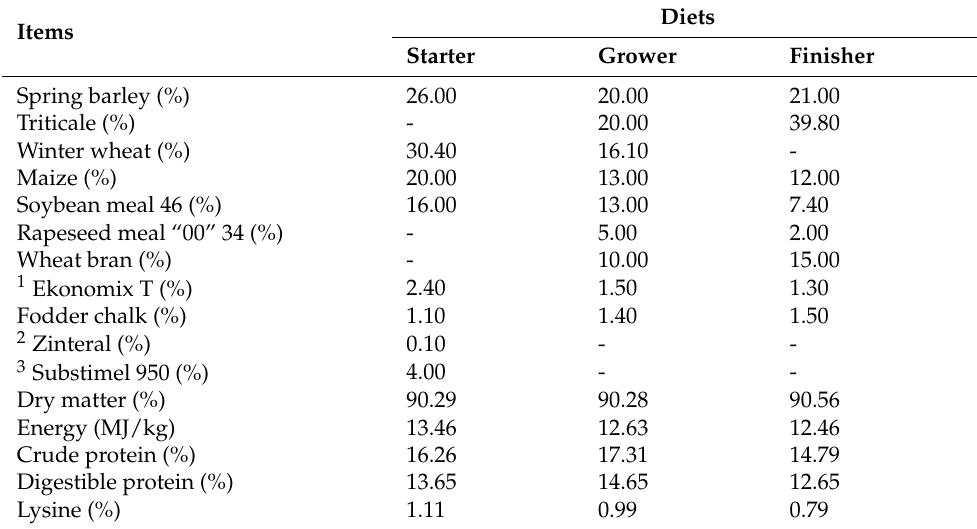
Table 1. Proximate composition of